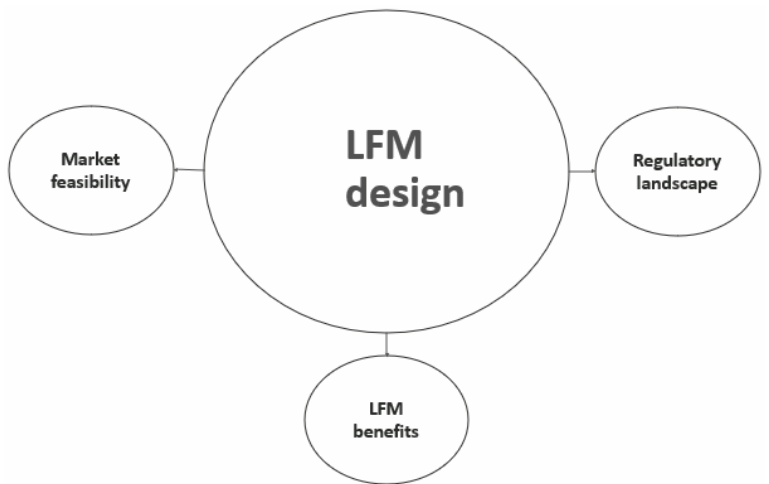
Figure 1. The components of LFM design.2.2. Platform Governance.